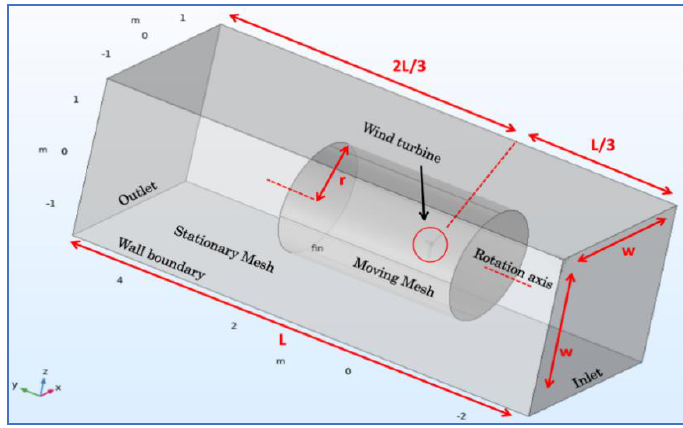
Figure 4. Simulation computational domain. Table 4. Dimensional characteristics of the computational domain.